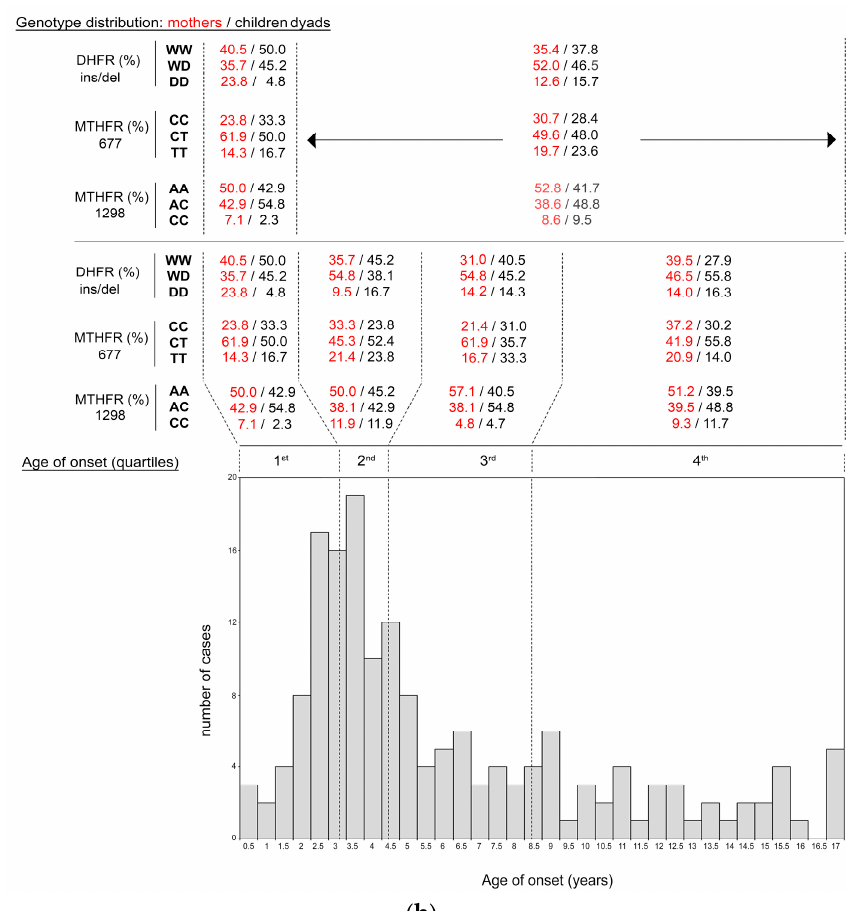
Figure 3. DHFR / MTHFR genotype distribution and ALL onset age. In panel ( a ), whole cohort of patients ( n = 235). In panel ( b ), mother-child dyad subgroup ( n = 196 subjects each). Genotype stratification is shown for both children and mothers in black and red, respectively. Genotype frequencies are reported as a percentage for each age quartile. Vertical dashed lines delimitate the quartiles of ALL onset age (1st, 2nd, 3rd, 4th). The number of cases (children and mothers) stratified, by DHFR / MTHFR genotypes and onset age quartiles, is shown in Table S3.